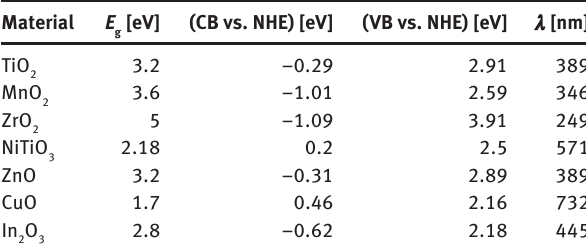
Table 1: Some materials used in light-driven micro/nanomotors with their energy